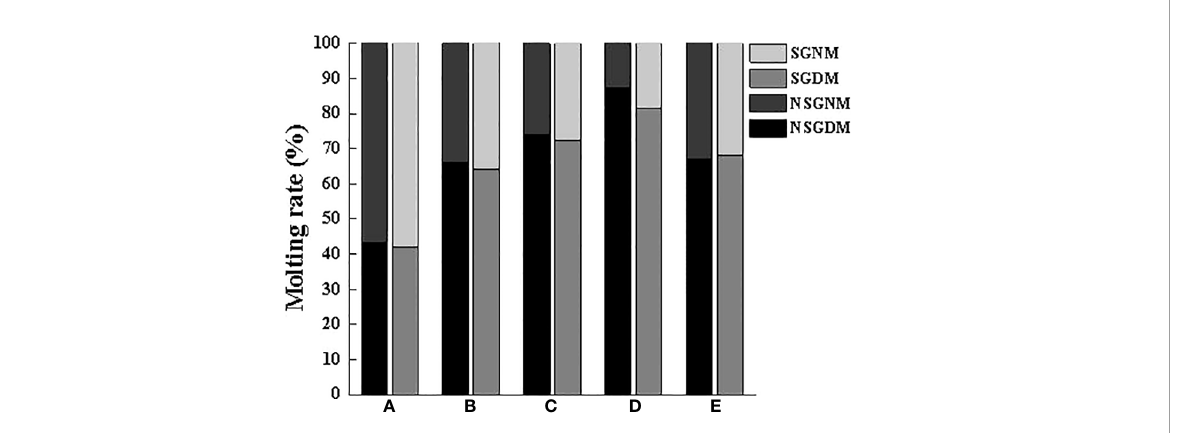
FIGURE 5 Molting rate of swimming crab in daytime and at night with different body weight groups in the presence and absence of shelters. NSGDM, No shelter group molting during the day; NSGNM, No shelter group molting during the night; SGDM, Shelter group molting during the day; SGNM, Shelter group molting during the night.